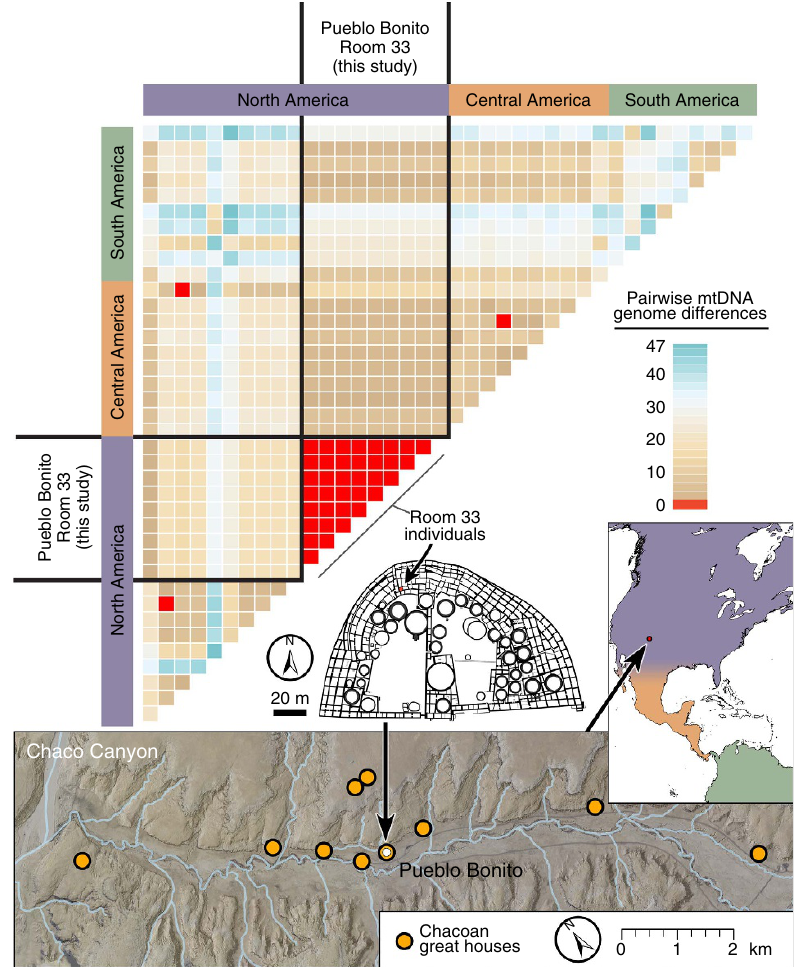
Figure 3 | Heatmap distance matrix of pairwise mitogenome comparisons. The number of nucleotide sequence differences between all pairs of 39 Native American complete mtDNA genomes, representing the 9 prehistoric Pueblo Bonito room 33 mtDNA genomes and those previously published for 10 individuals each from North, Central and South America. Positions with missing data or deletions in any individuals were removed from all pairwise comparisons (bp analysed ¼ 14,247). The non-Pueblo Bonito samples from each region were selected at random from an overall database of 171 complete mtDNA genomes (see Supplementary Fig. 5 for a pairwise distance matrix including all samples). (Graphical layout: T. Harper. All cartographic elements were produced in ArcGIS 10.4, with layout and design performed in Photoshop CC